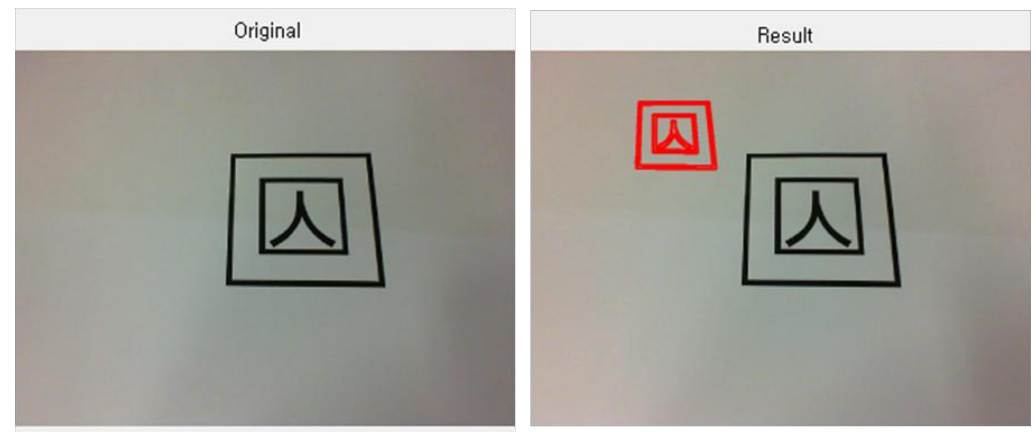
Figure 4. Copying and moving of the detected marker.